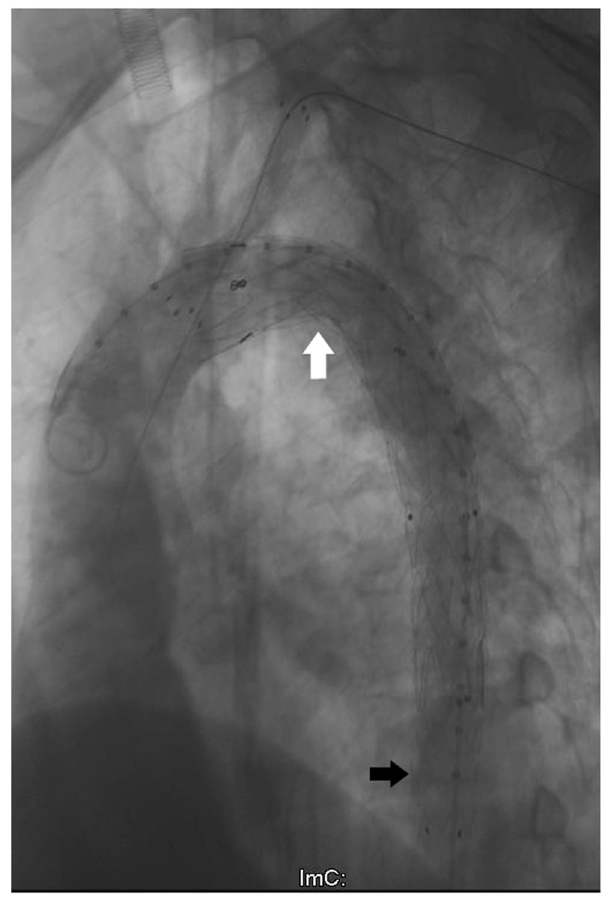
Figure 6. Angiography after stent graft deployment. The shape of arch accorded with the results of the simulation. The white arrow indicates the reshaping of the aortic arch, and the black arrow indicates the distal restrictive